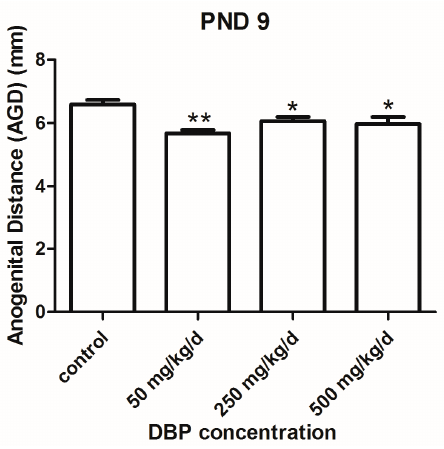
Figure 1. Effect of prenatal exposures to vehicle (oil) or to di-n-butyl phthalate (DBP) on anogenital distance (AGD) at Postnatal Day (PND) 9. Each bar is the mean ± SEM. ** p < 0.01; * p < 0.05, in comparison with control group. PND: Postnatal Day.